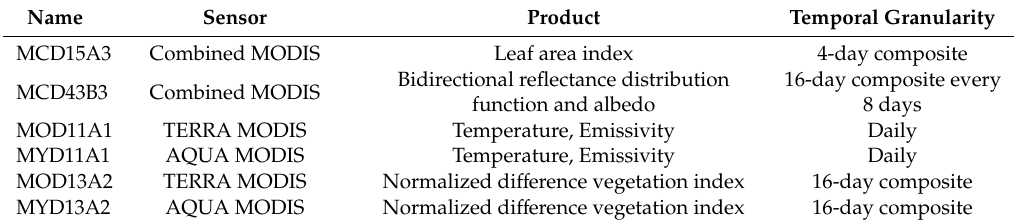
Table 1. Description of MODIS data used in this